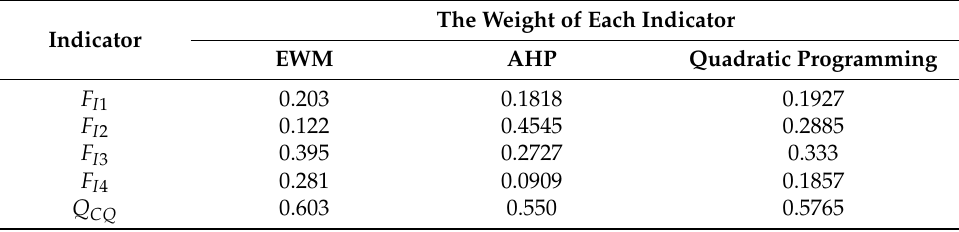
Table 2. Each indicator weight of completion quality.